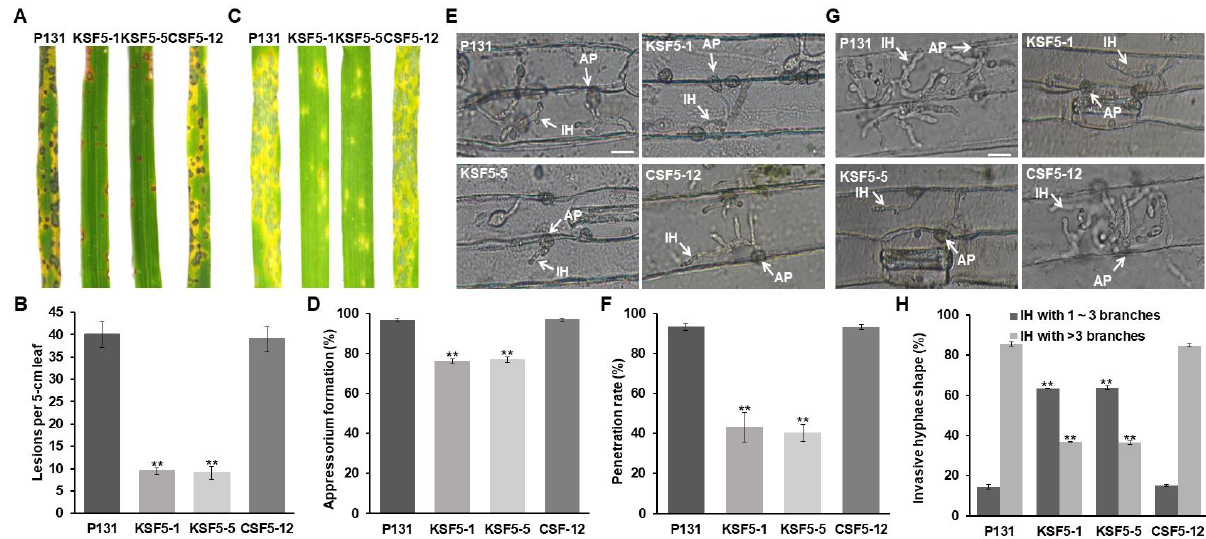
Figure 2. MoSNF5 is important to fungal virulence. ( A ) Rice seedlings sprayed with conidia of the wild-type strain P131, the ∆ Mosnf5 mutants KSF5 − 1 and KSF5 − 5, and its one complementation strain CSF5 − 12. Typical diseased leaves were photographed at 7 dpi. ( B ) Bar graphs showing the number of disease lesions on 5 cm rice leaf infected by strains P131, KSF5 − 1, KSF5 − 5, and CSF5 − 12. The mean and standard deviations were calculated based on three independent experiments by measuring 10 diseased leaves in each replicate. Asterisk marks a significant difference between the mutants and the P131 strain by using t -test ( p < 0.05). ( C ) Barley seedlings sprayed with conidia of strains P131, KSF5 − 1, KSF5 − 5, and CSF5 − 12. Typical diseased leaves were photographed at 5 dpi. ( D ) Percentages of appressorium formation of strains P131, KSF5 − 1, KSF5 − 5, and CSF5 − 12 on cover glass slides at 12 hpi. The mean and standard deviations were calculated based on three independent experiments by measuring 100 germinated conidia in each replicate. Asterisk marks a significant difference between the mutants and the P131 strain by using t -test ( p < 0.05). ( E ) Appressorial pene- tration of strains P131, KSF5 − 1, KSF5 − 5, and CSF5 − 12 on barley leaves at 24 hpi. AP, appressoria; IH, invasive hyphae. Bar, 20 µ m. ( F ) Percentages of appressorial penetration of strains P131, KSF5 − 1, KSF5 − 5, and CSF5 − 12 on barley leaves at 24 hpi. The mean and standard deviations were calculated based on three independent experiments by measuring 100 appressoria in each replicate. Asterisk marks a significant difference between the mutants and the P131 strain by using t -test ( p < 0.05). ( G ) Invasive hyphae of strains P131, KSF5 − 1, KSF5 − 5, and CSF5 − 12 on barley leaves at 36 hpi. AP, appressoria; IH, invasive hyphae. Bar, 20 µ m. ( H ) Percentages of invasive hyphae of strains P131, KSF5 − 1, KSF5 − 5, and CSF5 − 12 on barley leaves at 36 hpi. The invasive hyphae were classified into two main types, 1–3 branches and more than 3 branches. The mean and standard deviations were calculated based on three independent experiments by measuring 100 invasive hyphae in each replicate. Asterisk marks a significant difference between the mutants and the P131 strain by using t -test ( p <